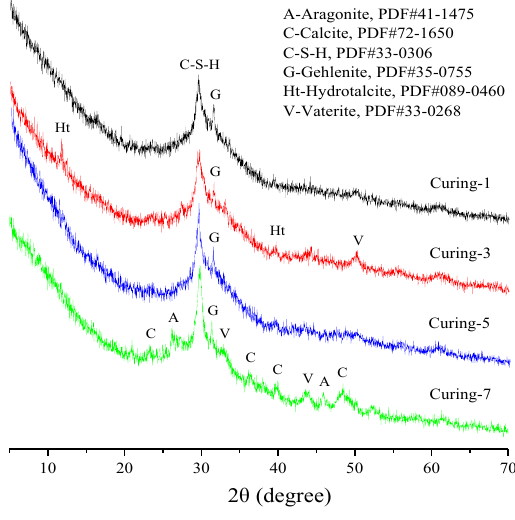
Figure 5. XRD analysis of AAS pastes.